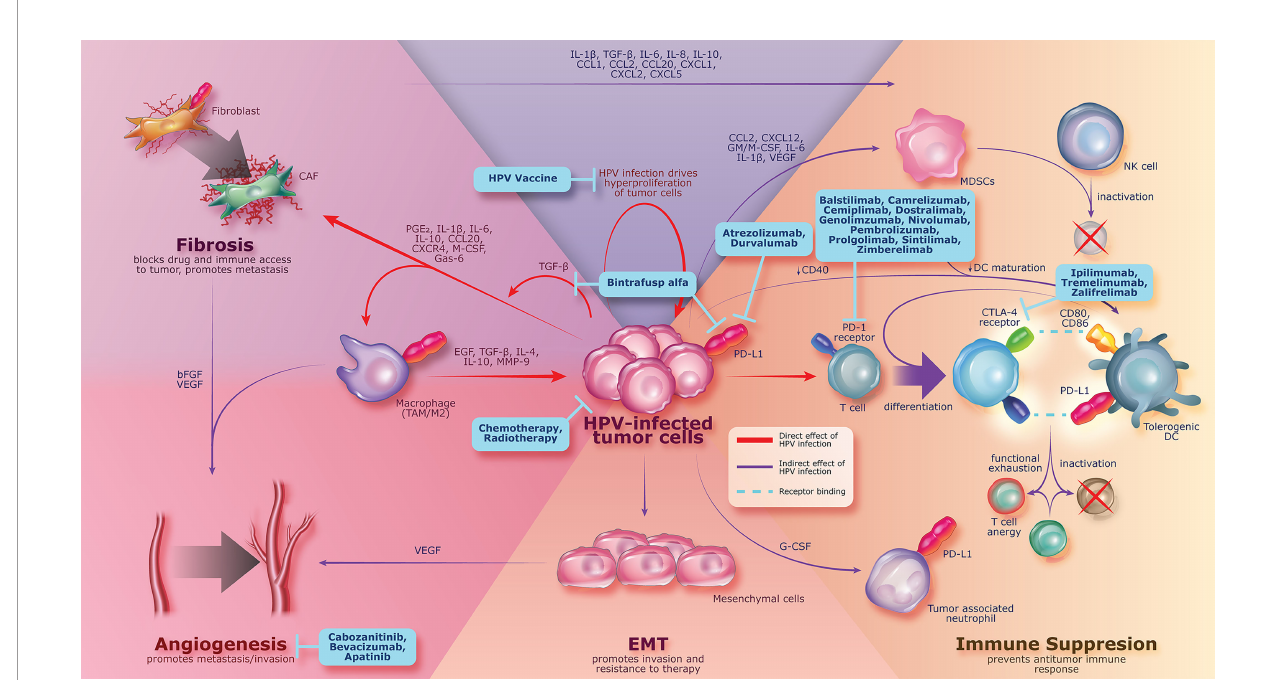
FIGURE 2 | Persistent HPV infection leading to pathogenesis of cervical cancer by increasing the expression of immunosuppressive proteins (e.g., TGF- b , PD-1, and PD-L1), which can promote tumorigenesis, angiogenesis, fi brosis, and immune suppression. Current treatment strategies are shown in blue boxes and include agents with activity against cancer-associated changes related to HPV infection. bFGF, basic fi broblast growth factor; CAF, cancer-associated fi broblast; CCL, chemokine C-C motif ligand; CD, cluster of differentiation; CTLA-4, cytotoxic T-lymphocyte protein 4; CXCL, chemokine C-X-C motif ligand; DC, dendritic cell; EGF, epidermal growth factor; EMT, epithelial-mesenchymal transition; Gas, growth arrest-speci fi c protein; G/M-CSF, granulocyte/macrophage colony-stimulating factor; HPV, human papillomavirus; IL, interleukin; MDSC, myeloid-derived suppressor cell; MMP, matrix metallopeptidase; NK, natural killer; PD-1, programmed death 1; PD-L1, programmed death ligand 1; PGE 2 , prostaglandin E 2 ; TAM, tumor-associated macrophage; TGF- b , transforming growth factor b ; VEGF, vascular endothelial growth